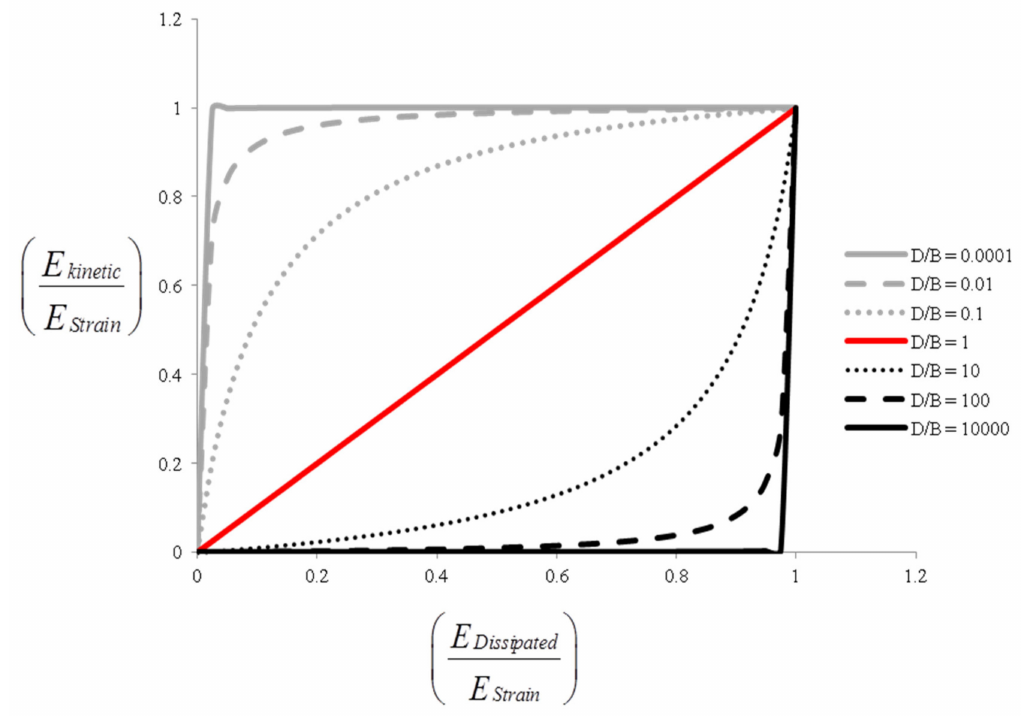
Figure 5. The interaction between the di ff erent types of energy due to the e ff ect of the damage in a coal mass and strata layers ( D / B = 10 n